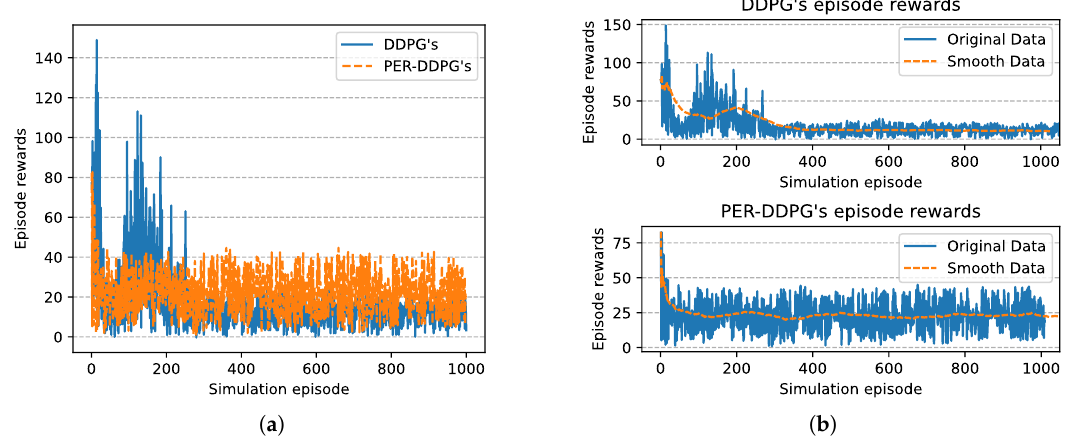
Figure 9. The episode rewards of algorithms based on UER-DDPG and PER-DDPG over simulation episode. ( a ) The comparison of episode rewards based on UER-DDPG and PER-DDPG. ( b ) The top figure is the episode rewards of algorithm based on UER-DDPG, and the bottom figure is the episode rewards of algorithm based on PER-DDPG.